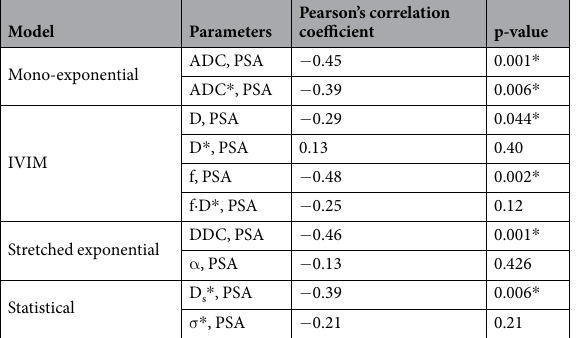
Table 3. Pearson’s correlation coefficients and corresponding p-values between the PSA and each of the various diffusion parameters. Statistically significant values are designated by an asterisk.